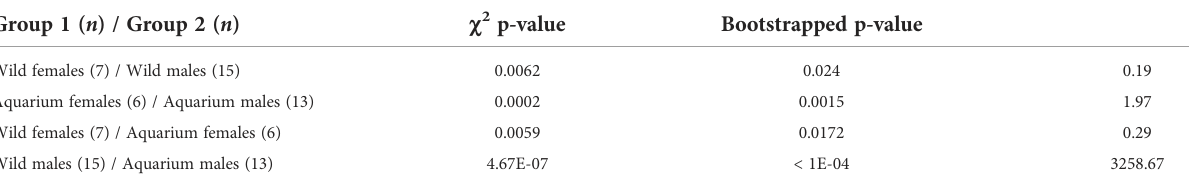
TABLE 4 Comparison of growth parameters between groups.